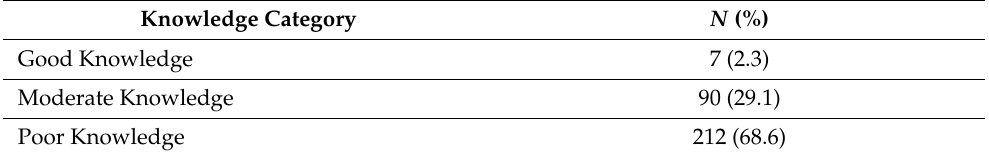
Table 4. Descriptive statistics of the knowledge categories.